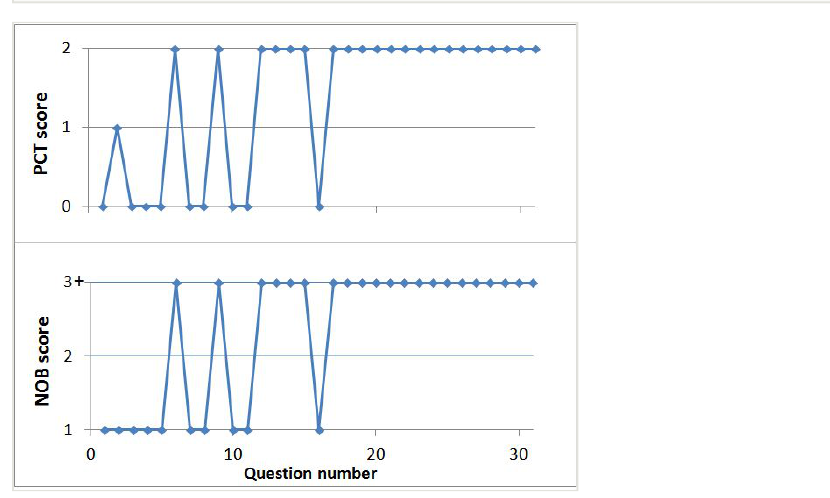
Graphical representation of neurobiological requirements for WISC-V, Matrix Reasoning. The NOB score (bottom) and the PCT score (top) as a function of question number.